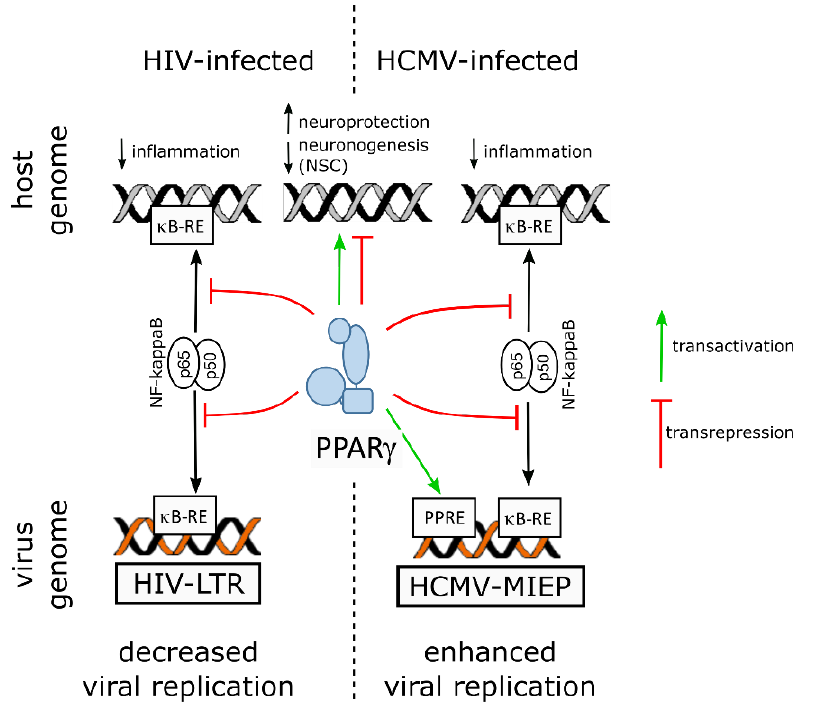
Figure 3. Graphical summary of PPARγ involvement during infection by HIV ( left ) or HCMV ( right ). In HIV-infected cells, PPAR γ inhibits NF-kB by transrepression (red lines), thereby downregulating inflammatory genes and decreasing the efficiency of viral replication. In contrast, in HCMV-infected cells, PPARγ enhances viral replication by transactivation (green arrow) of the HCMV major immediate early promoter (MIEP) through two PPAR responsive elements (PPRE). In both cases, PPARγ regulates expression of the host cell genome, contributing to neuroprotection and, in neural stem cells (NSC), inhibition of neuronogenesis. ĸ B-RE: NF- γB responsive element.